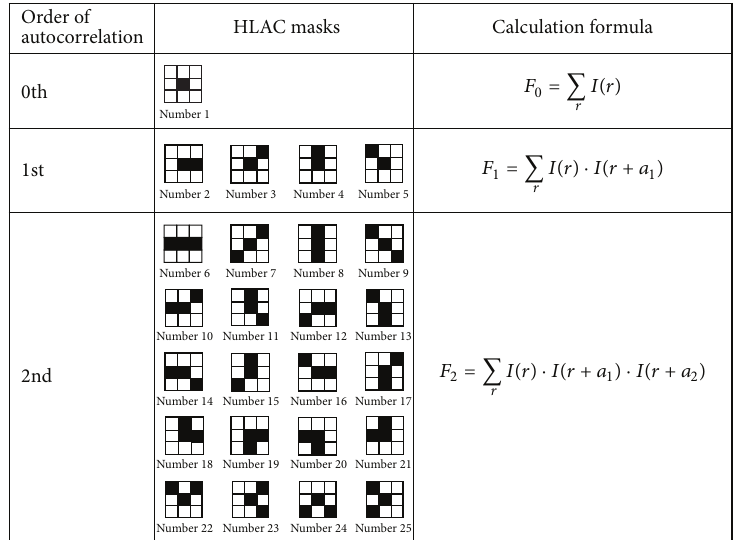
Figure 4: HLAC masks up to second-order autocorrelation for the proposed retrieving method.